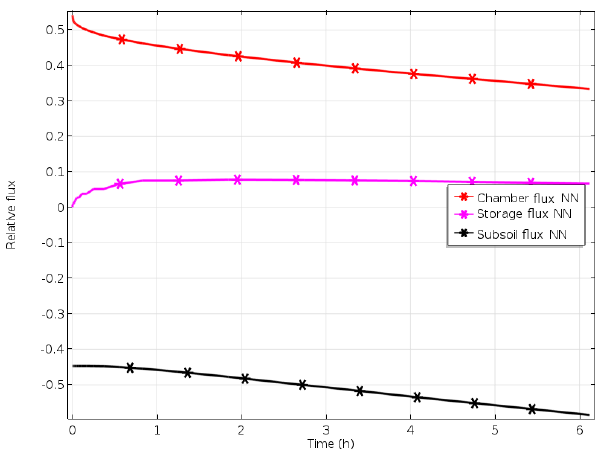
Figure 3. Relative fluxes of 15 N 15 N after chamber closing in sce- nario A_bottom_open.